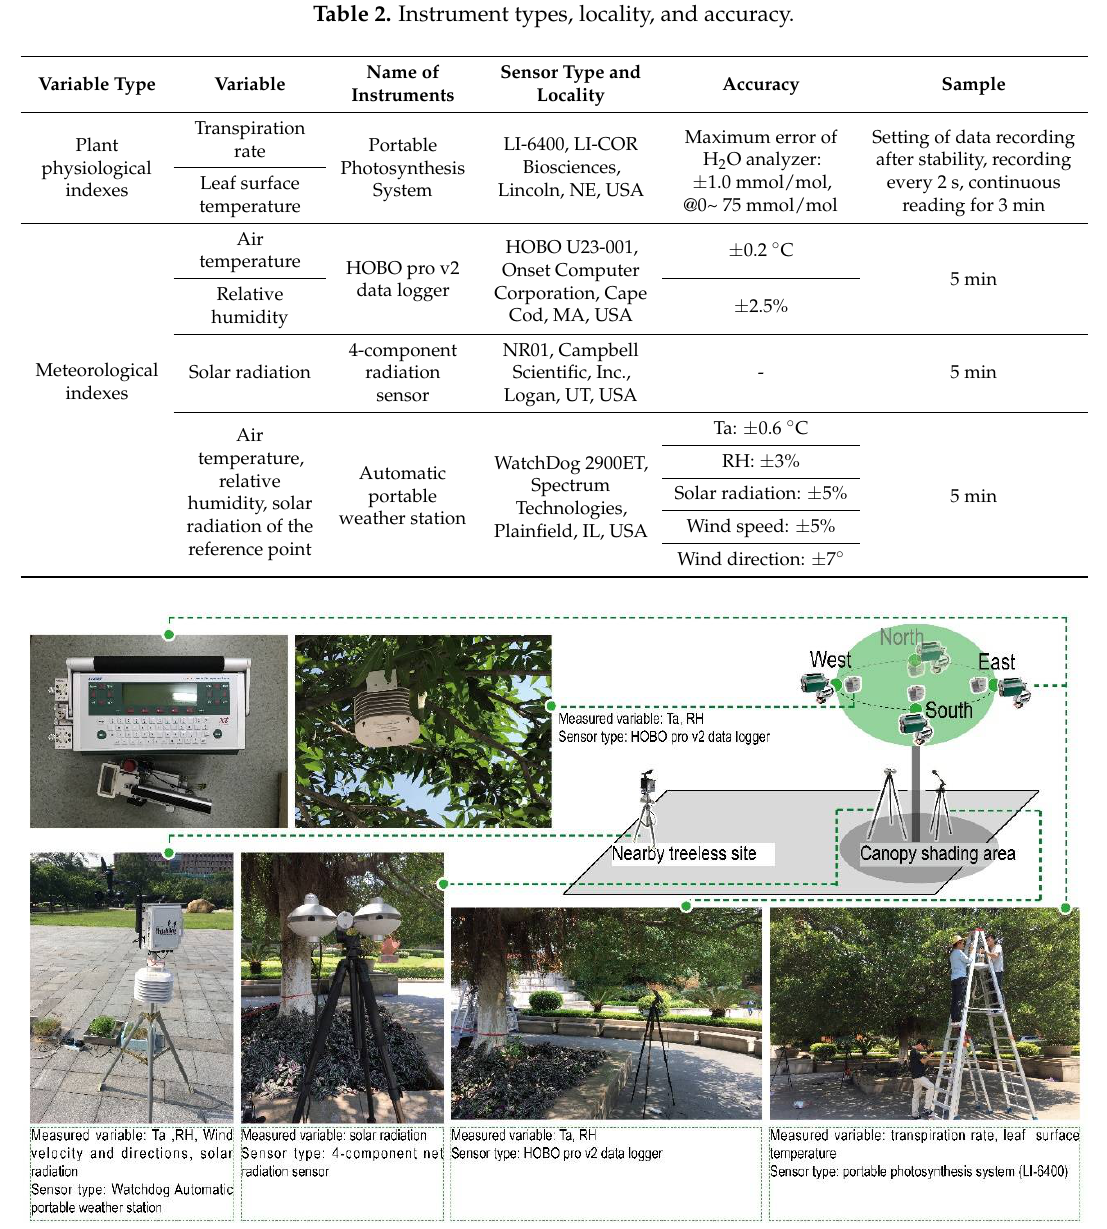
Figure 2. The locations of measuring instruments. RH: relative humidity; Ta: air temperature.